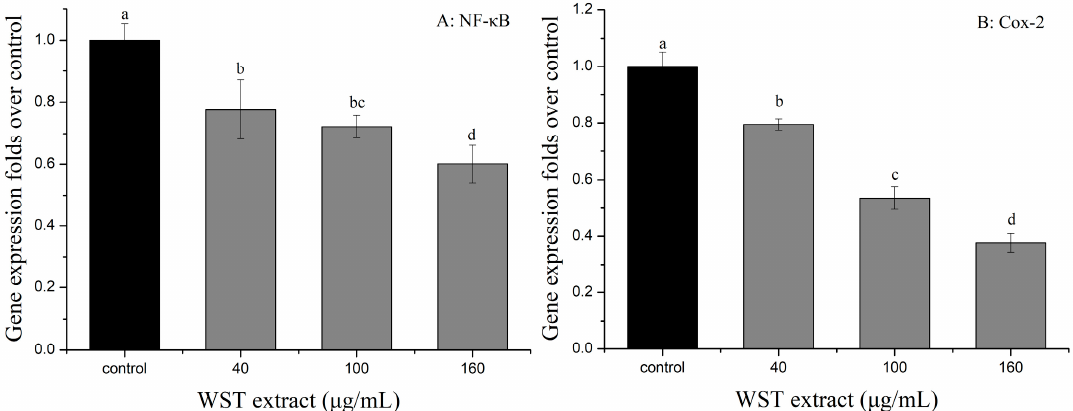
Figure 6. Effects of WST extracts on the gene expression of NF- κ B ( A ) and Cox-2 ( B ) in human hepatoma HepG2 cells. Fold ratio of NF- κ B ( A ) and Cox-2 ( B ) mRNA expression over the control. The calculation formula is as follows: gene expression/GAPDH × control numerical value (control fold ratio: 1). a–d Mean values with different letters in the same bar graph are significantly different ( p < 0.05) according to Duncan’s multiple range test.